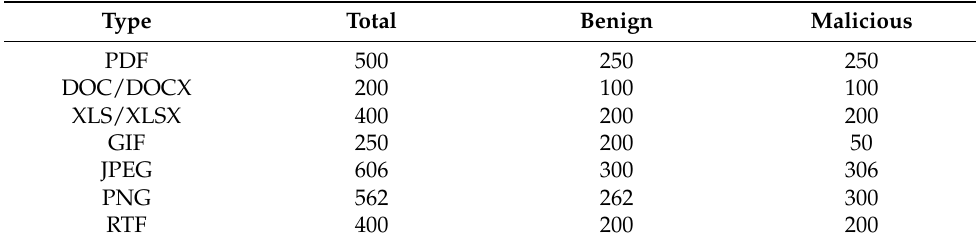
Table 5. The distribution of Dataset2.